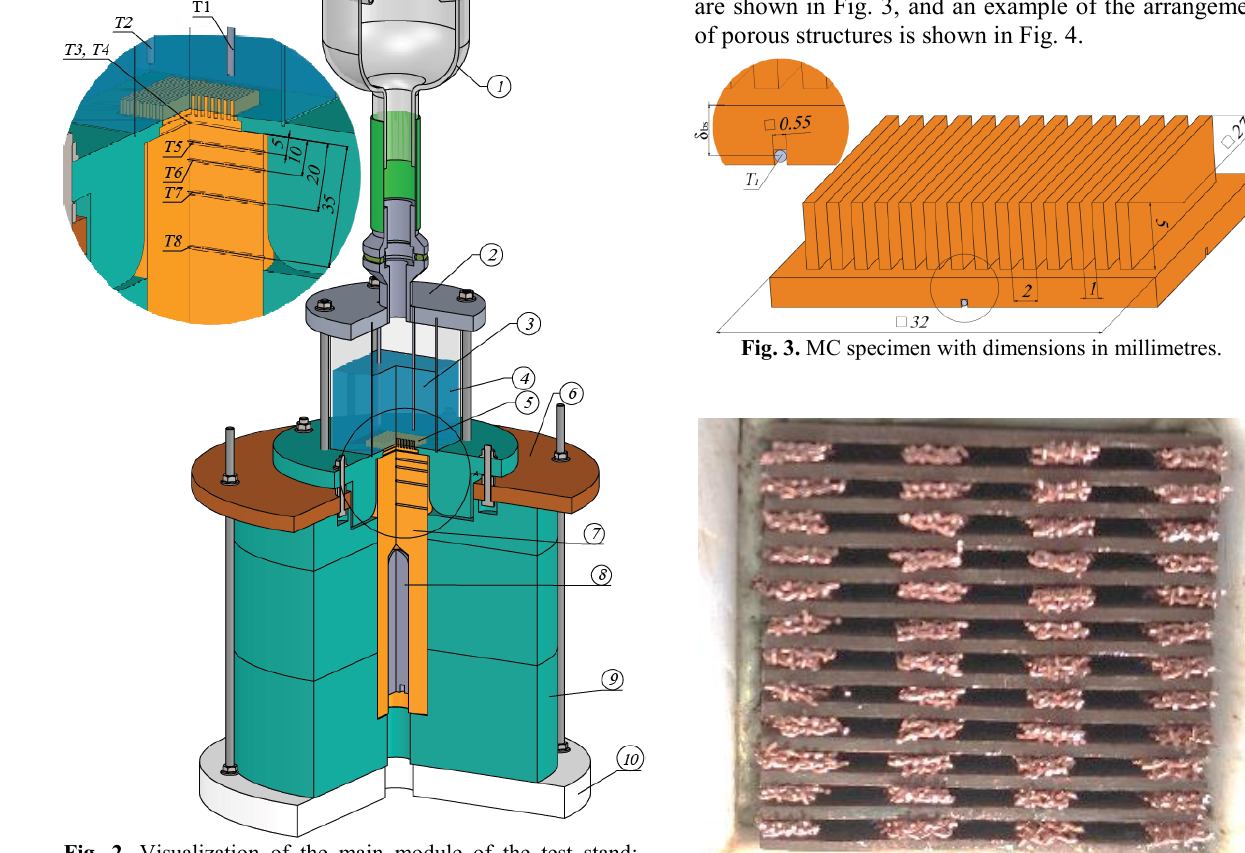
Fig. 4. Example of the wire mesh arrangement for the MCC-M- 7.6-0.5-2 specimen. length of the filling ( l p ) and mesh aperture ( a p ). Fig. 5 shows the surface MCC-M-3.5-0.5-2 with markings described in Table 1.